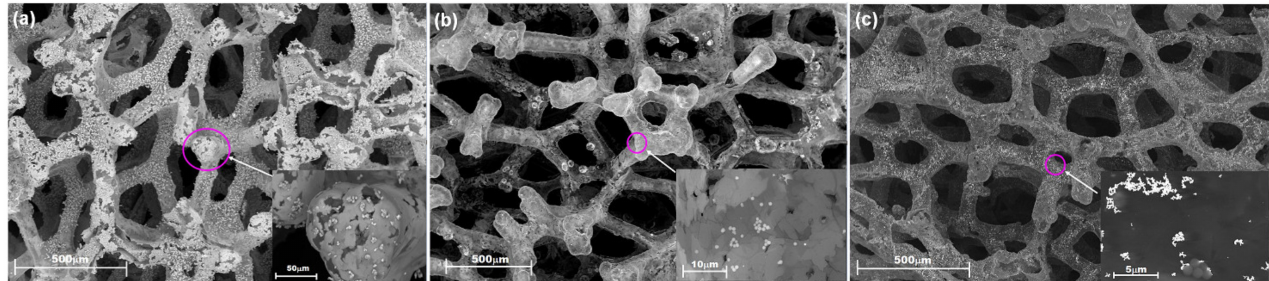
Figure 3. Top view and enlarged morphology of ( a ) pristine porous graphene after Ni scrapping; ( b ) graphene foam doped with nitrogen; and ( c ) platinum functionalized graphene